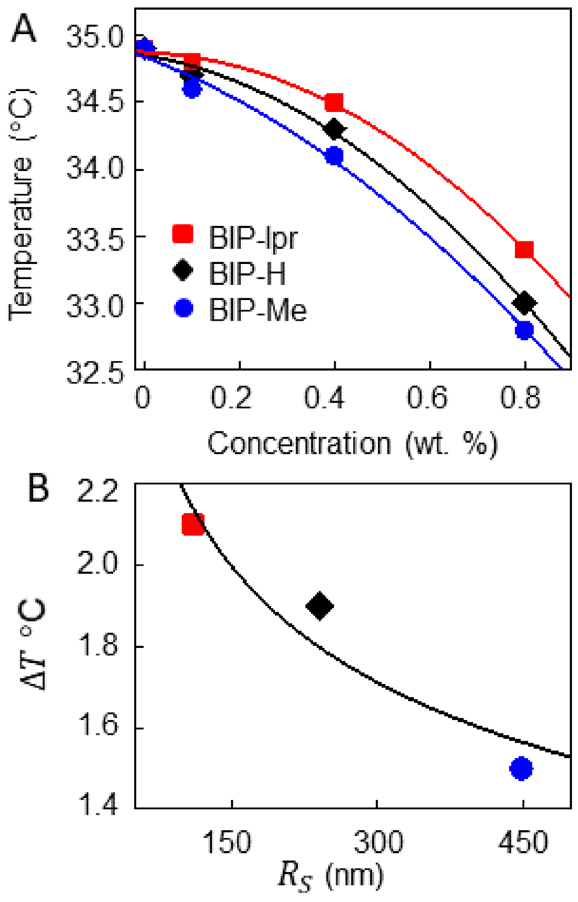
Figure 4. ( A ) DSC results summarized for the three BIP ligands, plotting the 5CB isotropic-nematic transition temperature with increasing ligand concentration. ( B ) Average shell radius R S varying with the change in the transition temperature (cid:31) T for each ligand. The fit is explained in the